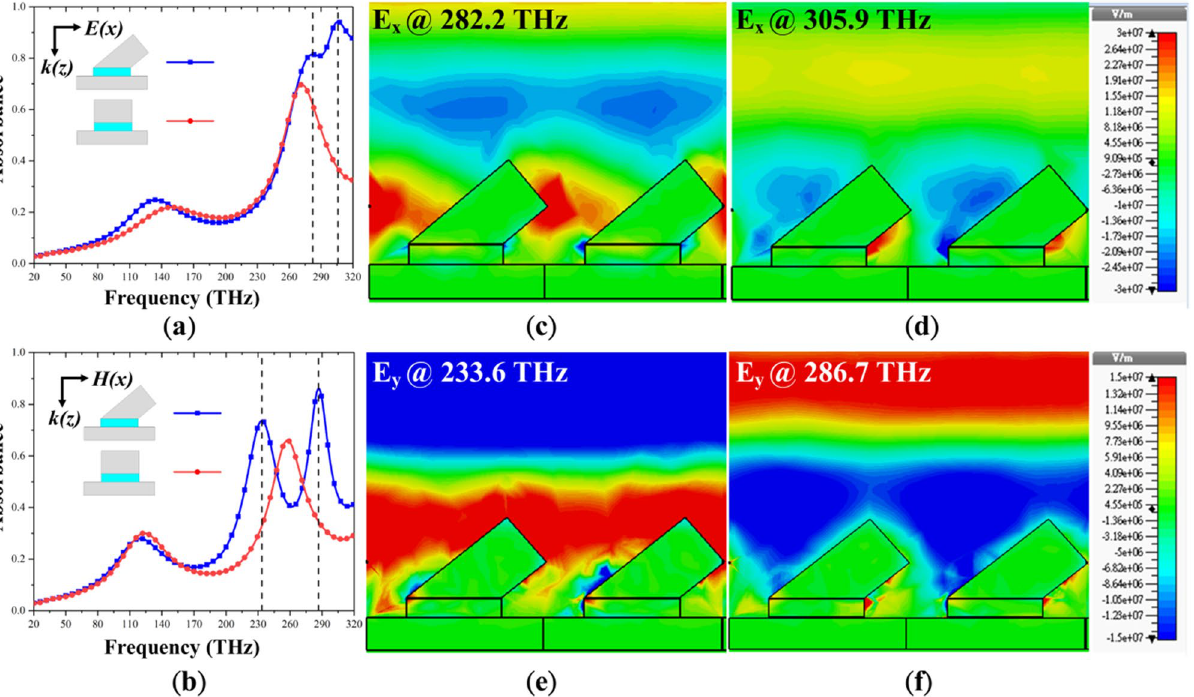
Figure 2. Absorbance of the SOFS and planar MPAs under normal incidence at ( a ) x- and ( b ) y-polarization, respectively. Absorbance of the SOFS MPA are larger than the ones of the planar MPA for both polarizations. Recorded field distributions of the SOFS MPA at the two absorbance peaks for ( c , d ) x- and ( e , f ) y-polarization. Field distributions indicate that an oblique flat sheet could provide different penetration routes (top edge and bottom side) for the incoming wave, thus providing a different phase change for resonance.